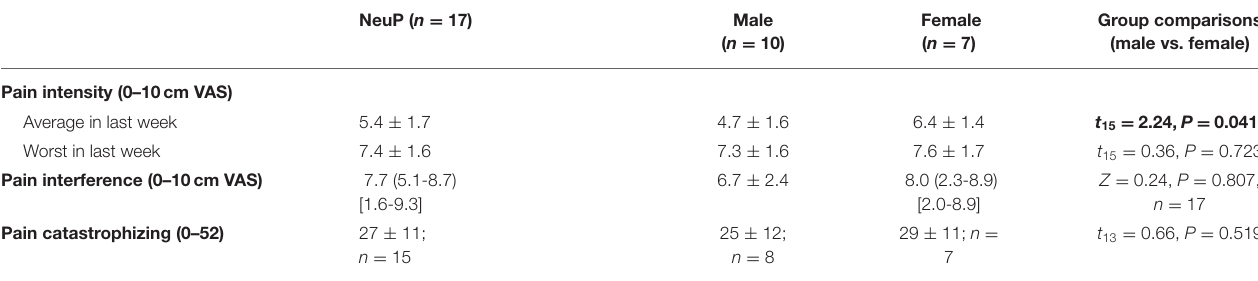
TABLE 3 | Pain intensity and interference ratings and pain catastrophizing scores in patients with NeuP.